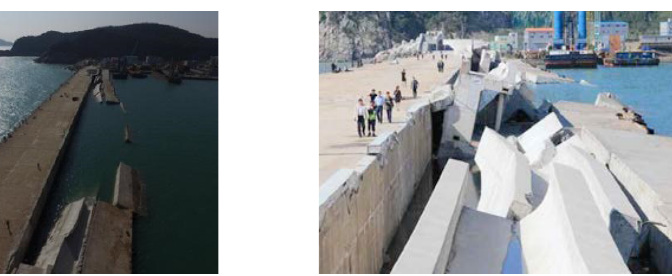
Figure 1. Critical damage to the facilities.